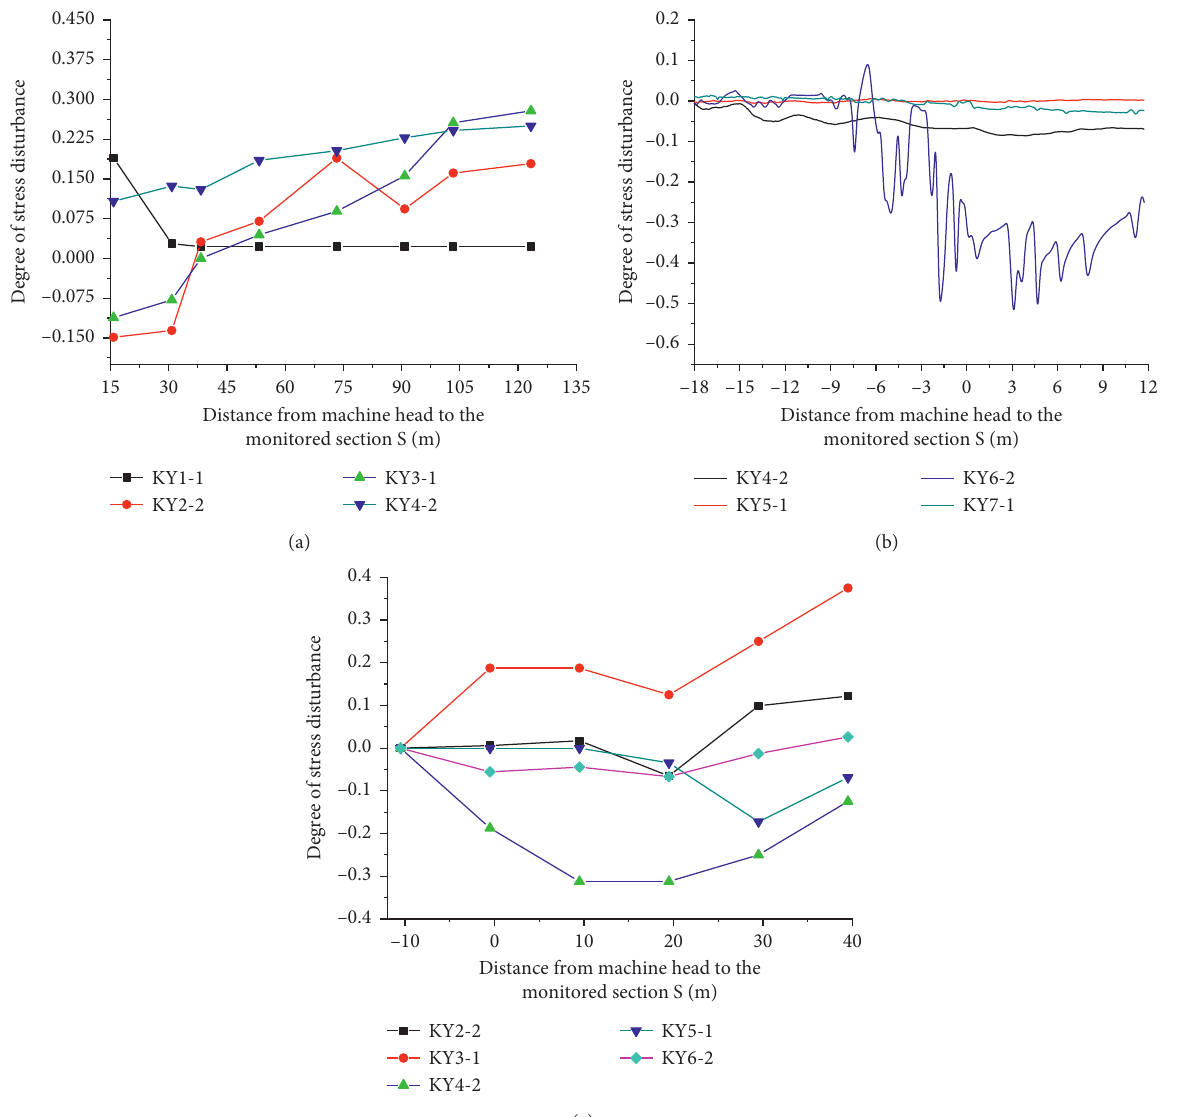
Figure 16: Degree of soil disturbance under different lateral spacing. (a) Hole 1 excavates. (b) Hole 3 excavates. (c) Hole 2